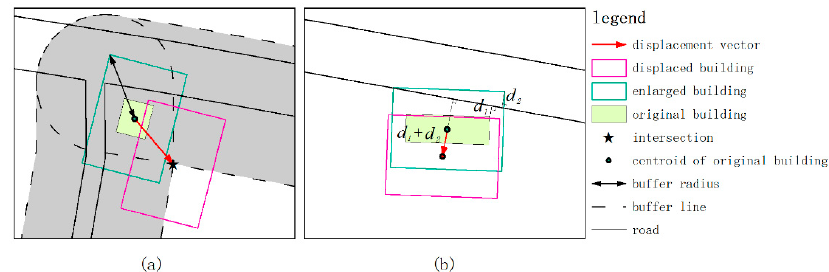
Figure 15. Determination of the building displacement vector for: ( a ) a C-type building; ( b ) an E-type building.